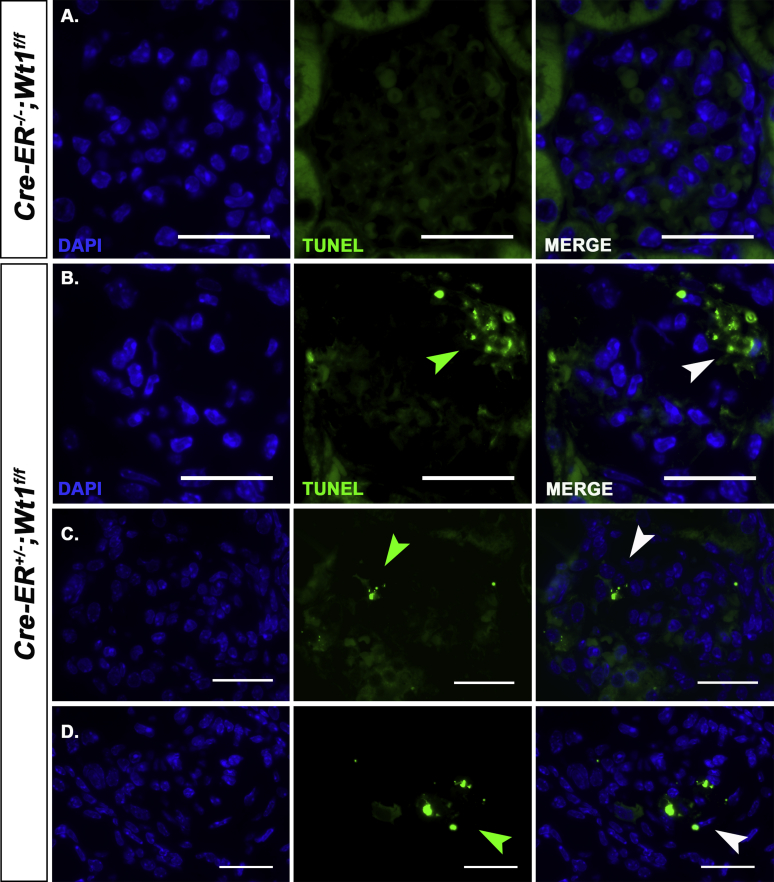
Terminal deoxynucleotidyltransferase–mediated 2′-deoxyuridine 5′-triphosphate nick end-labeling (TUNEL)-positive cells in glomeruli of CAGG-CreERTM+/−;Wt1f/f transgenic mice at day (D) 12 postinduction (PI). (A-D) Shown are micrographs of glomeruli of transgenic mouse kidney tissue sections labeled with TUNEL (green arrows) and counterstained with 4′,6-diamidino-2-phenylindole (DAPI) at D12 PI. Bars = 25 μm. (A) CAGG-CreERTM−/−;Wt1f/f controls display no TUNEL-positive cells in the glomerulus. (B-D) Representative micrographs for D12 PI CAGG-CreERTM−/−;Wt1f/f mutants exhibiting TUNEL-DAPI-positive cells in the glomeruli. See also Figure 2c for TUNEL-positive primary podocytes of mutant versus control mice.